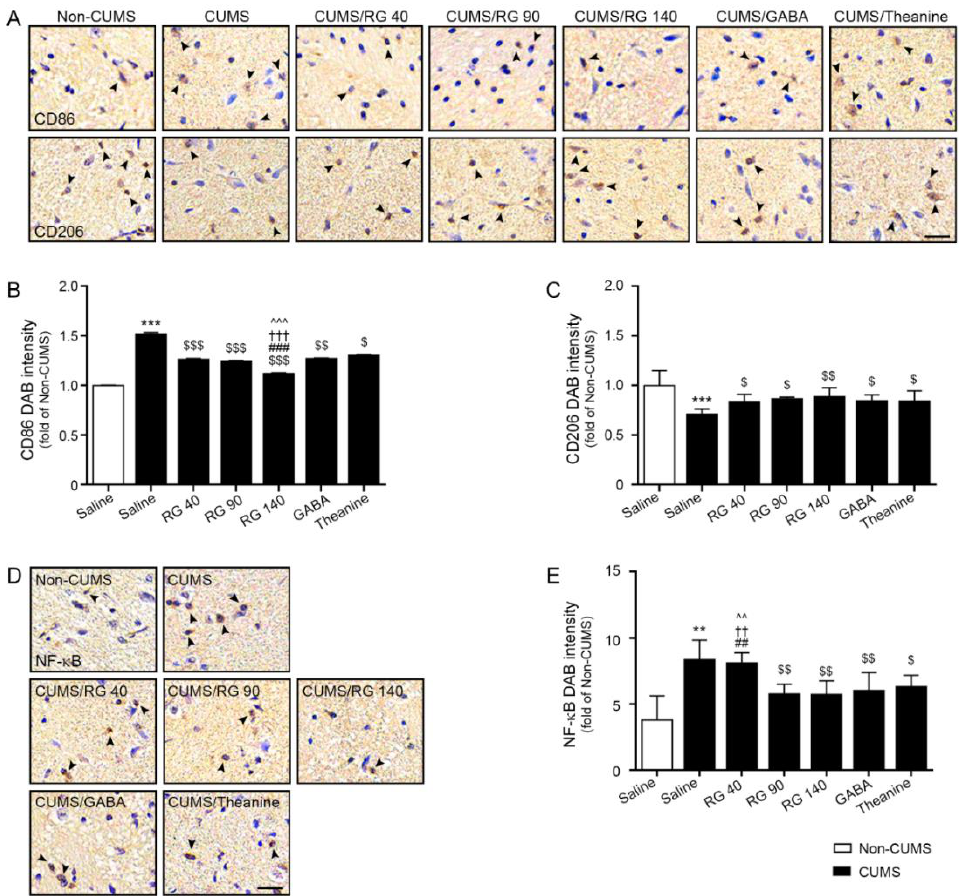
Figure 2. Effect of NF- κ B reduction due to M1 reduction and M2 elevation by RG in the hypothalamus of CUMS mice model. ( A ) The expression levels of CD86 (M1 marker; upper lane in ( A )), CD206 (M2 marker; lower lane in ( A )), and NF- κ B ( D ) in the hypothalamus of CUMS were validated using DAB staining (scale bar = 200 µ m). Arrows point positive signals; ( B , C , E ) Quantification graphs are depicted in ( A , D ). The expression levels of CD86 ( B ) and NF- κ B ( E ) increased in CUMS relative to those in the control. However, their expression decreased after RG, GABA, and theanine treatment. CD206 ( C ) expression decreased in CUMS compared to that in the Non-CUMS. However, their expression increased after RG, GABA, and theanine treatment. Data are presented as the mean ± SD ( n = 3/group). CD206, cluster of differentiation 206; CD86, cluster of differentiation 86; CUMS, chronic unpredictable mild stress; DAB, 3,3′ -diaminobenzidine; GABA, gamma-aminobutyric acid; RG, rice germ with 30% GABA; NF- κ B, nuclear factor kappa-light-chain-enhancer of activated B cells. **, p < 0.01 and ***, p < 0.05 vs. Non-CUMS; $, p < 0.05, $$, p < 0.01 and, $$$, p < 0.001 vs. CUMS; ##, p < 0.01 and ###, p < 0.001 vs. CUMS/RG90; ††, p < 0.01 and †††, p < 0.001 vs. CUMS/GABA; ˆˆ, p < 0.01 and ˆˆˆ, p < 0.001 vs. CUMS/Theanine. CUMS significantly decreased CD206 (M2 marker) expression. It was increased by the administration of RG (40, 90, and 140 mg/kg), GABA, and theanine. The reduction effects of RG (40, 90, and 140 mg/kg), GABA, and theanine did not differ significantly (Figure